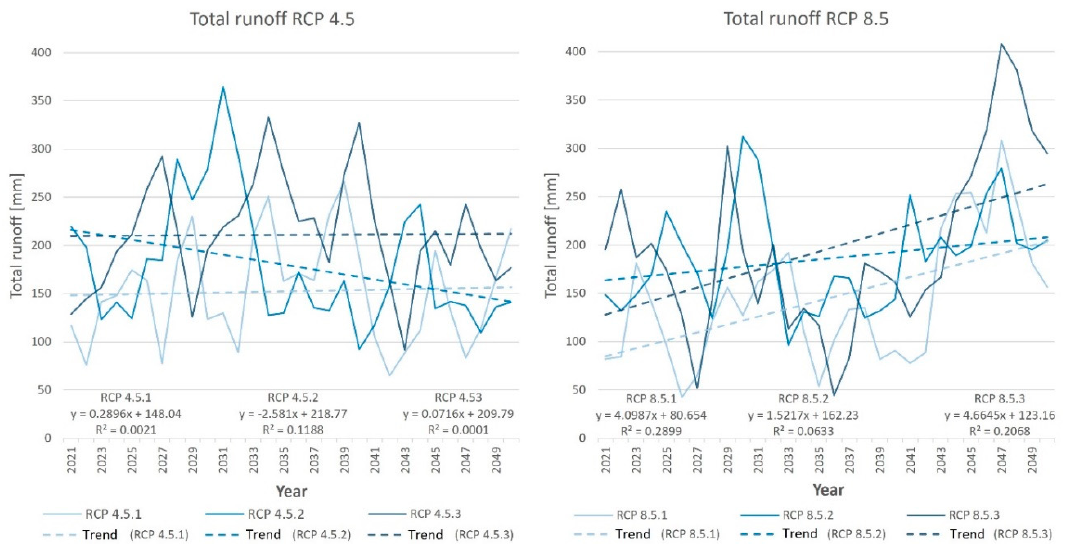
Figure 14. Average annual sum of total runoff in the Bystra River basin in the years 2021–2050 for individual climate projections in the RCP 4.5 and RCP 8.5 scenarios with trend lines (own study). The average monthly total runoff for the Bystra River basin will be lower in most climate change projections in the years 2021–2030, 2031–2040, and 2041–2050 (Table 10). The exceptions will be the RCP 4.5.3 (2031–2040) and RCP 8.5.2, RCP 8.5.3 (2041–2050) projections, where the average total monthly runoff will be higher compared to the 2010–2017 simulation years. Table 10. Comparison of the average monthly total runoff for the SWAT simulation period 2010– 2017 with individual projections for the RCP 4.5 and RCP 8.5 climate change scenarios for the pe- riods 2021–2030, 2031–2040, and 2041–2050 (own study). Climate Model